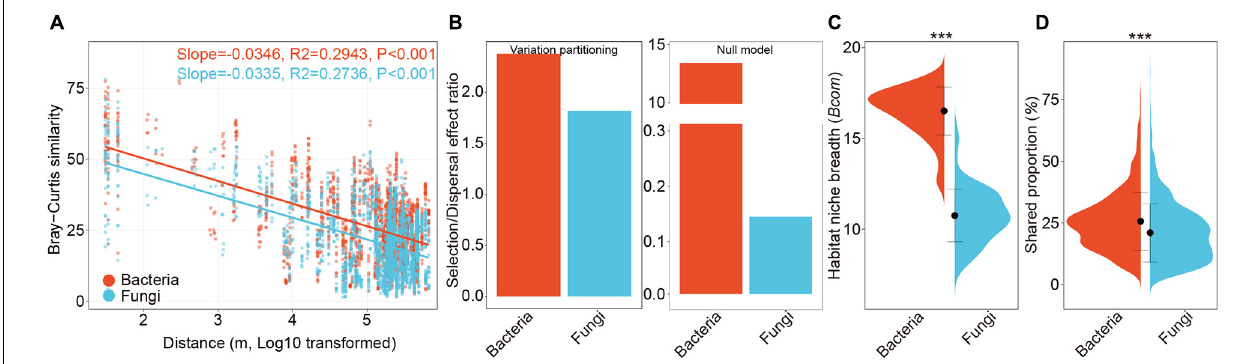
FIGURE 3 | Biogeographic patterns and ecological processes of bacterial and fungal communities. (A) Distance-decay relationships showing Bray-Curtis similarities of bacterial and fungal communities against spatial distance among sampling sites. Solid lines denote the fitness of ordinary least-squares regressions. (B) Selection/dispersal limitation ratio of bacterial and fungal communities estimated by variation partitioning analyses and null model analyses. (C) Violin plots illustrating mean habitat niche breadth from all OTUs in each sample ( Bcom ) of bacterial versus fungal communities. Black dot represents the mean value of Bcom and error bars indicate standard deviation. (D) Violin plots showing mean shared proportions (%) of sequences of bacterial and fungal communities, which represents the potential dispersal abilities (D) . The significance of difference between bacteria and fungi were determined by Wilcoxon rank sum test. ***, P < 0.001.